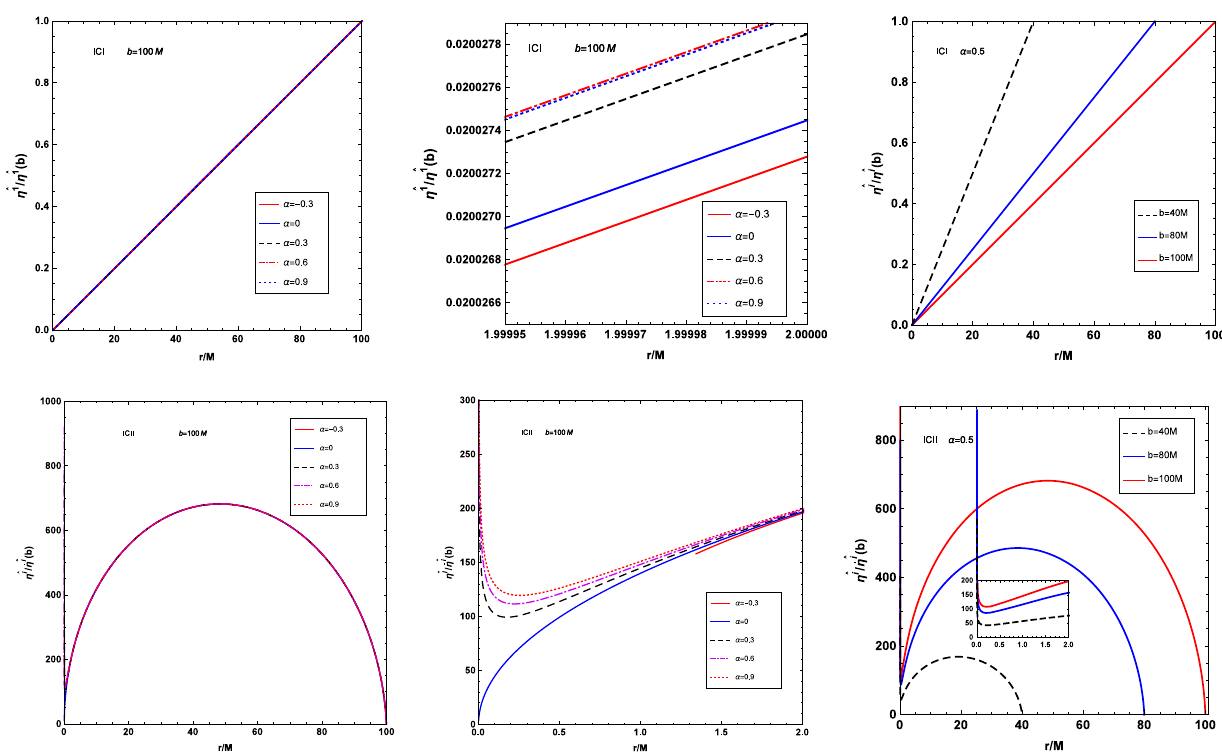
ˆ i Fig. 4 Angular components η ICII, respectively. The middle panel in each row is the corresponding of the deviation vector for different the partial enlarged detail of the deviation vector in the left Gauss–Bonnet coupling constant α and the initial radial positions b . The left and right panels are related to the initial conditions ICI and